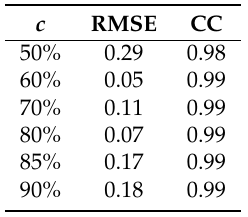
Table 1. Statistics describing the goodness of fit of Equation (9).